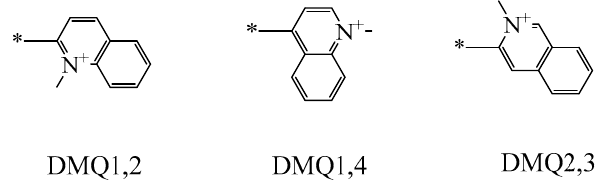
Figure 18. Molecular structures of DA-DMQ1,4-T, DA-DMQ1,2-T, and DA-DMQ2,3-T.